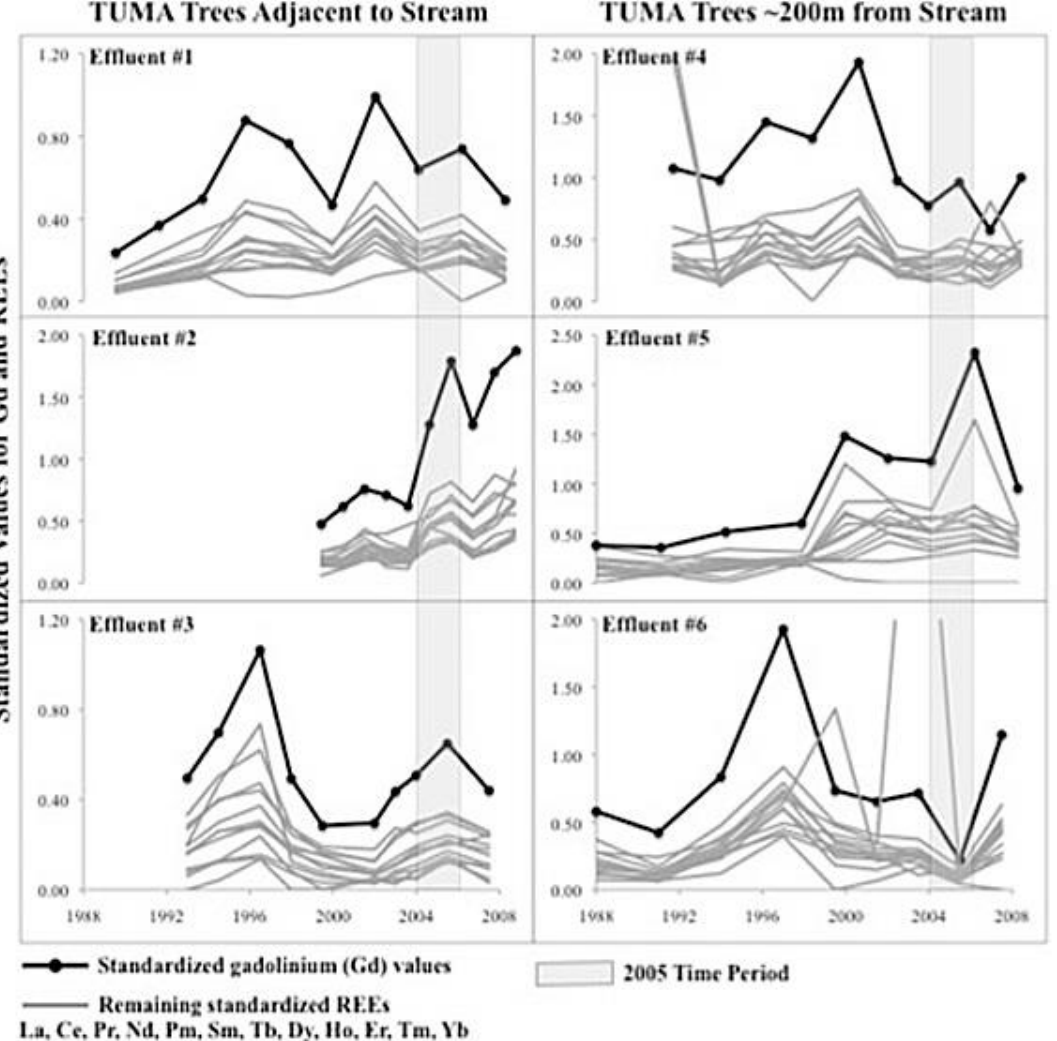
Figure 4. Relative concentrations of REEs in three cottonwood trees adjacent to the effluent-dominated stream ( left column ) and ~200 m west of the effluent-dominated stream ( right column ). The light gray bar highlights the 2005 time-period.